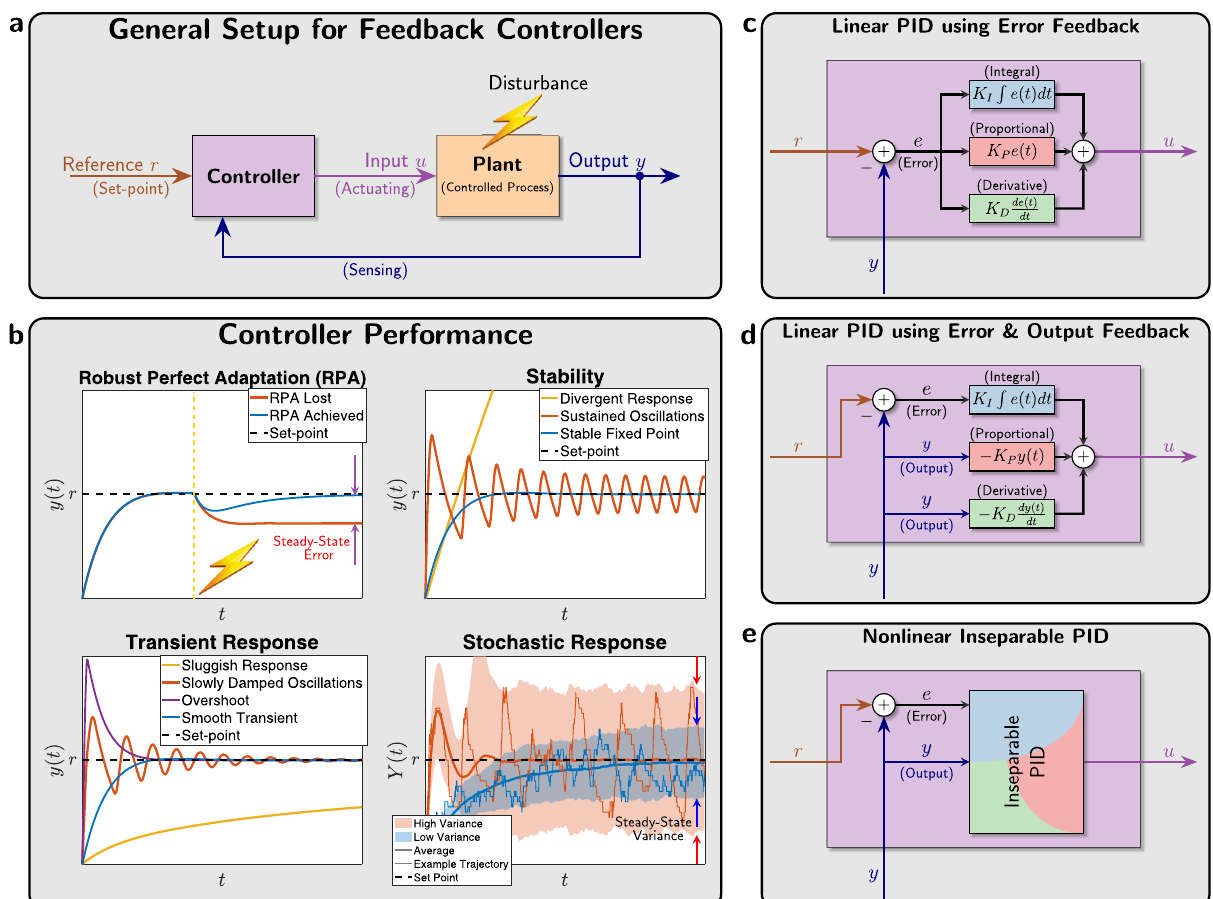
Fig. 1 Feedback controller design and performance. a The output to be controlled is fed back into the controller via a sensing mechanism. The controller exploits the setpoint, which is typically “ dialed in" by the user and computes the suitable control action to be applied to the plant (or process) via an actuation mechanism. The goal of the control action is to steer the output to the desired setpoint despite external or even internal disturbances. b A demonstration of four performance goals that are typically targeted when designing the controller. Robust perfect adaptation (RPA): this is the biological analog of the notion of robust steady-state tracking (RSST) that is well known in control theory 61 . A controller achieves RPA if it drives the steady state of the plant output y to the setpoint (or reference, denoted by r ) despite varying initial conditions, plant uncertainties and/or constant disturbances. Stability enhancement: a typical goal of a controller